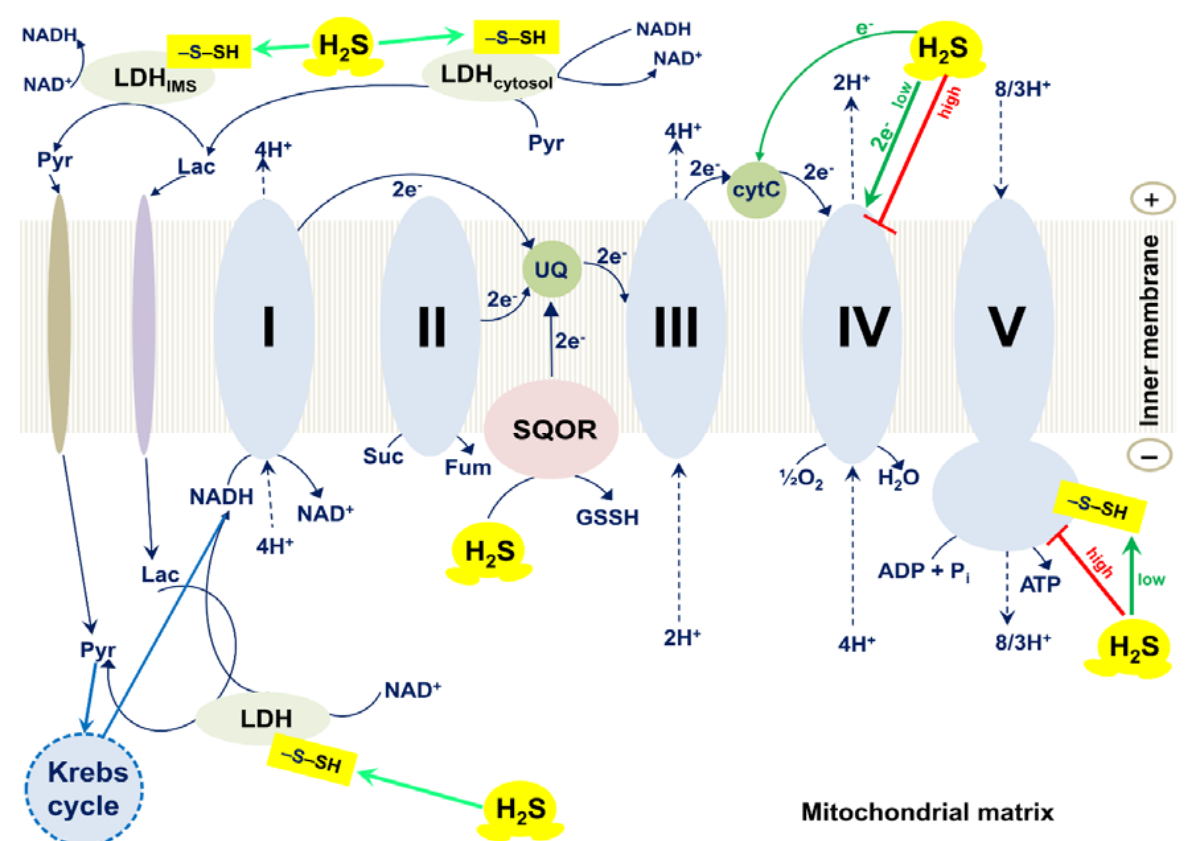
Figure 4. Effects of H 2 S on mammalian mitochondrial electron transport chain, ATP synthase, and lactate dehydrogenase. The mammalian respiratory chain includes four different membrane-bound complexes: I, II, III, and IV. H 2 S at low concentrations stimulates the activity of F o F 1 -ATP synthase (also known as complex V) via S -sulfhydration of Cys244 or Cys294 of its α subunit [30]. H 2 S increases the activity of lactate dehydrogenase (LDH) via S -sulfhydration of its Cys163 that, in turn, stimulates mitochondrial electron transport [31]. H 2 S can also donate electrons to the respiratory chain via sulfide quinone oxidoreductase (SQOR) by directly reducing ubiquinone (UQ) [32]. At high (toxic) concentrations H 2 S inhibits complex IV (cytochrome c oxidase) and F o F 1 -ATP synthase that leads to reversible inhibition of mitochondrial electron transport and ATP production [30,33–35]. At low concentrations H 2 S serves as an electron donor for complex IV, either directly [36–38] or indirectly, via reduction of its native substrate cytochrome c [39]. The outer mitochondrial membrane is not shown for